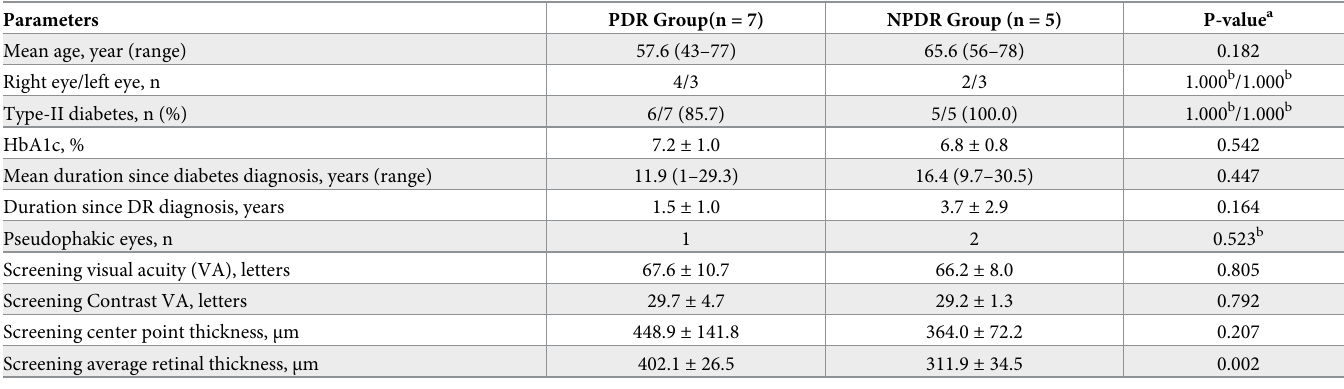
Table 1. Patient demographics and screening values.